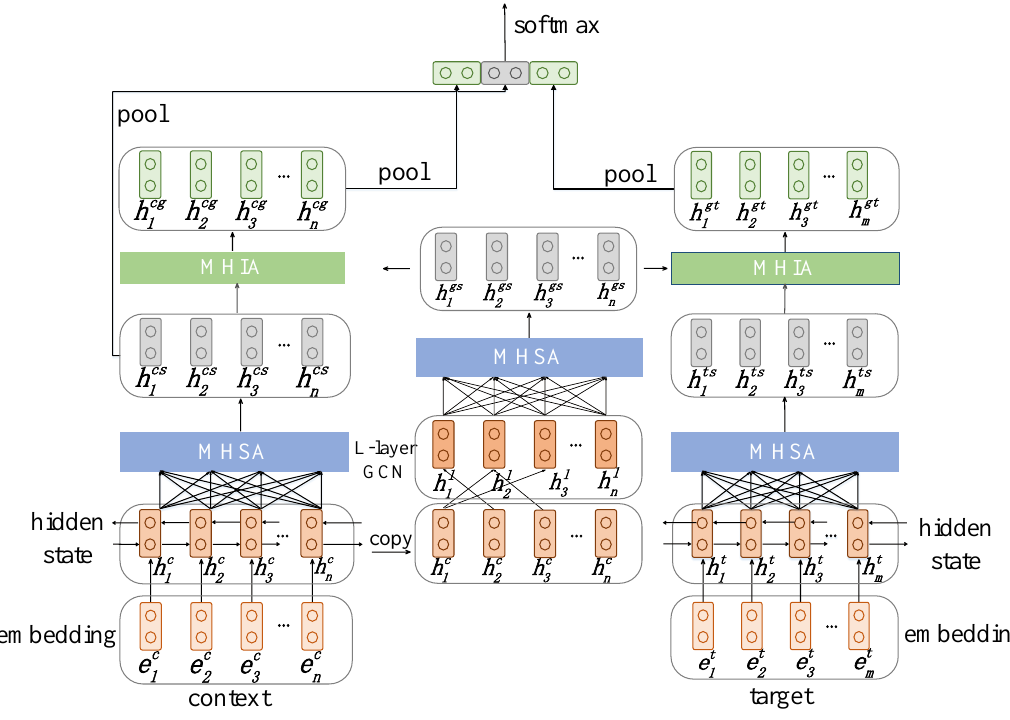
Figure 2. The overall architecture of the attentional-encoding-based graph convolutional network (AEGCN). MHIA: multi-head interactive attention; MHSA: multi-head